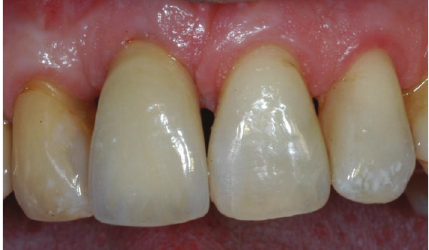
Figure 20: The definitive, ceramo-metallic restoration in